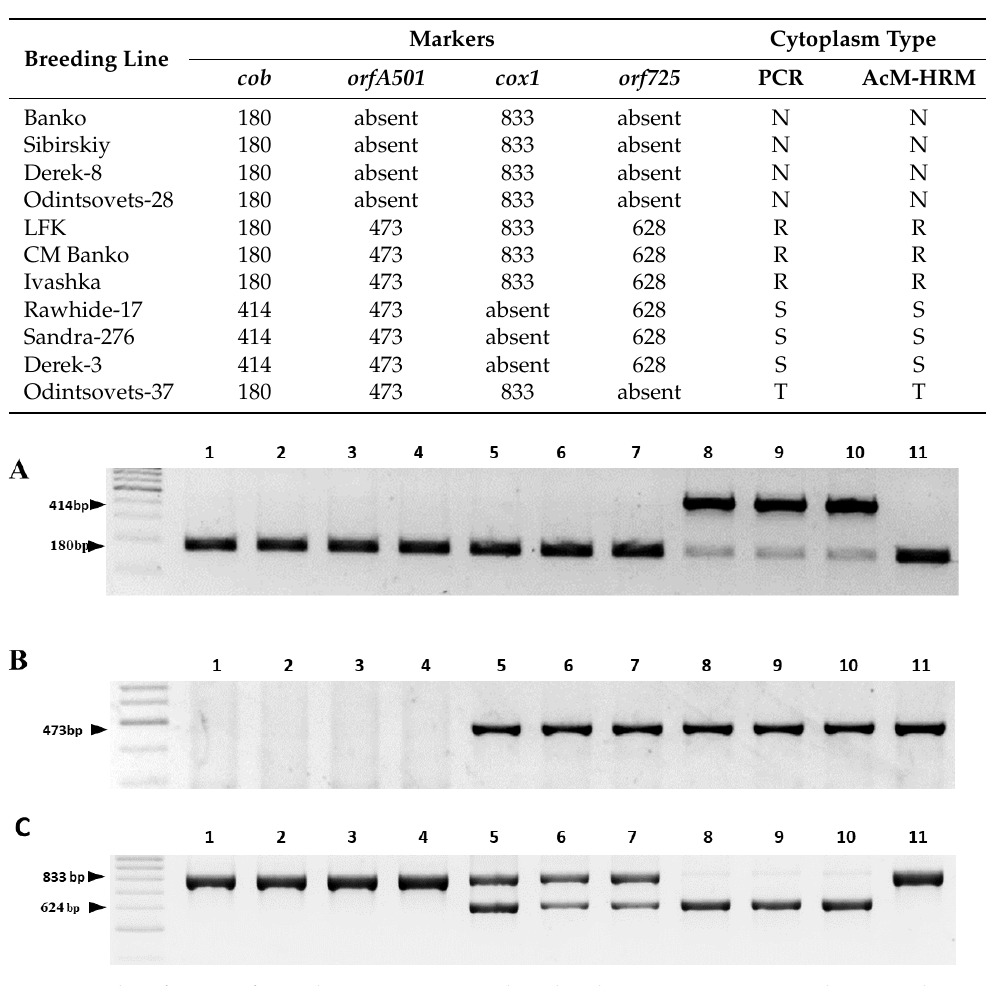
Figure 5. Identification of cytoplasm types in onion breeding lines using conventional PCR marker